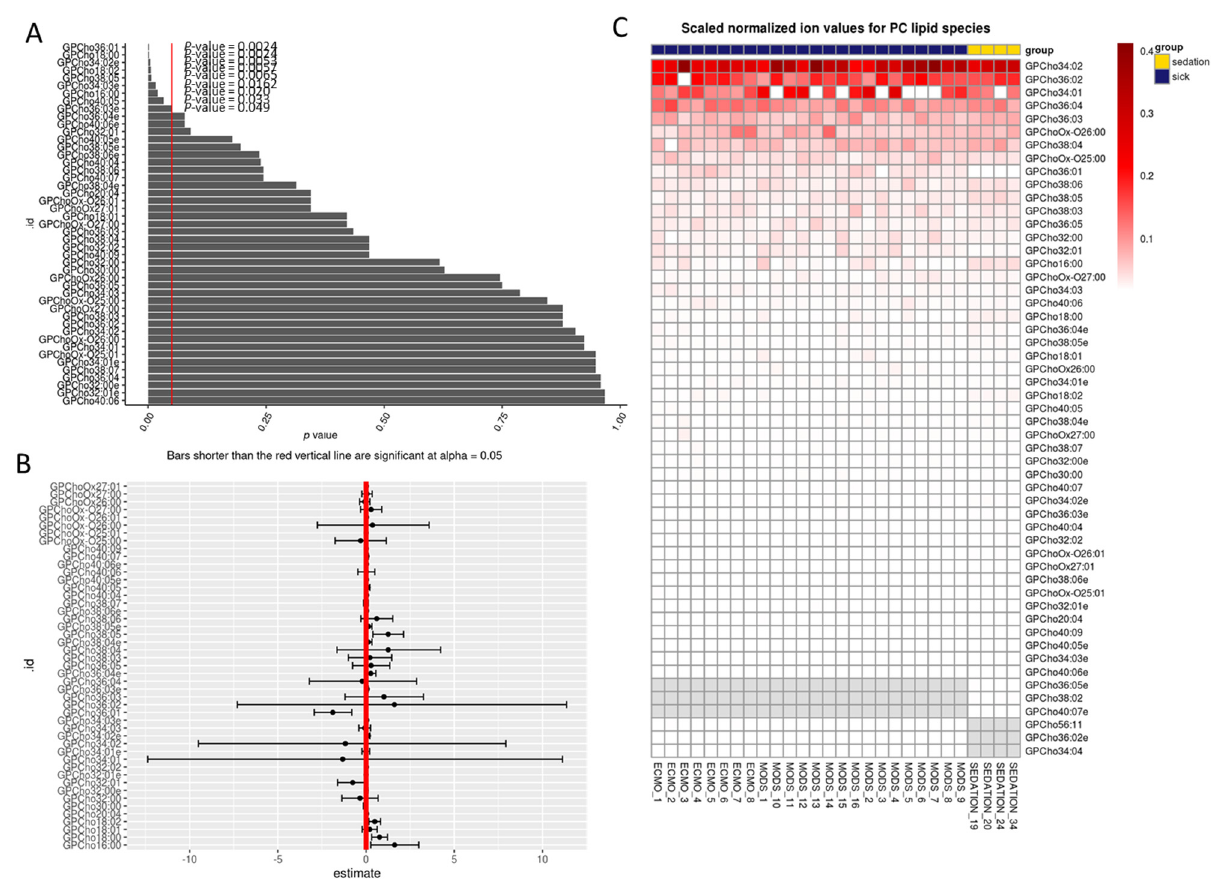
Figure 2. Percent total glycerophosphotidylcholine lipid species at baseline. ( A ) Bar chart of p -values from regression output from log-transformed data; red line indicates 0.05. Any p-value that crosses 0.05 is not statistically significant. ( B ) Points in B represent the mean log (fold-change) in odds between sick and sedation groups. The error bars in B, represent the upper and lower bounds of the false-coverage for the estimate. 95% false coverage intervals of the mean log (fold-change) in odds; red line indicates 0. Any confidence interval that crosses 0 is not statistically significant. ( C ) Scaled values of total lipids based on absolute normalized ion abundances per ml of plasma; GPC: glycerophosphotidlycholine.